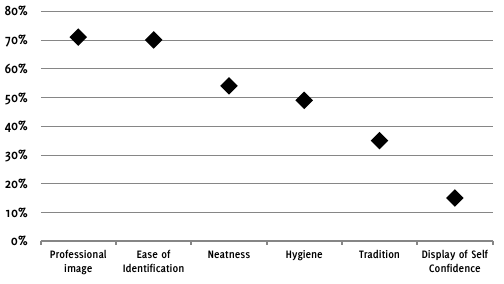
Figure 2. Patients’ Acceptance on Physician’s Attire Pre- and Post Disclosure of Potential Microbial